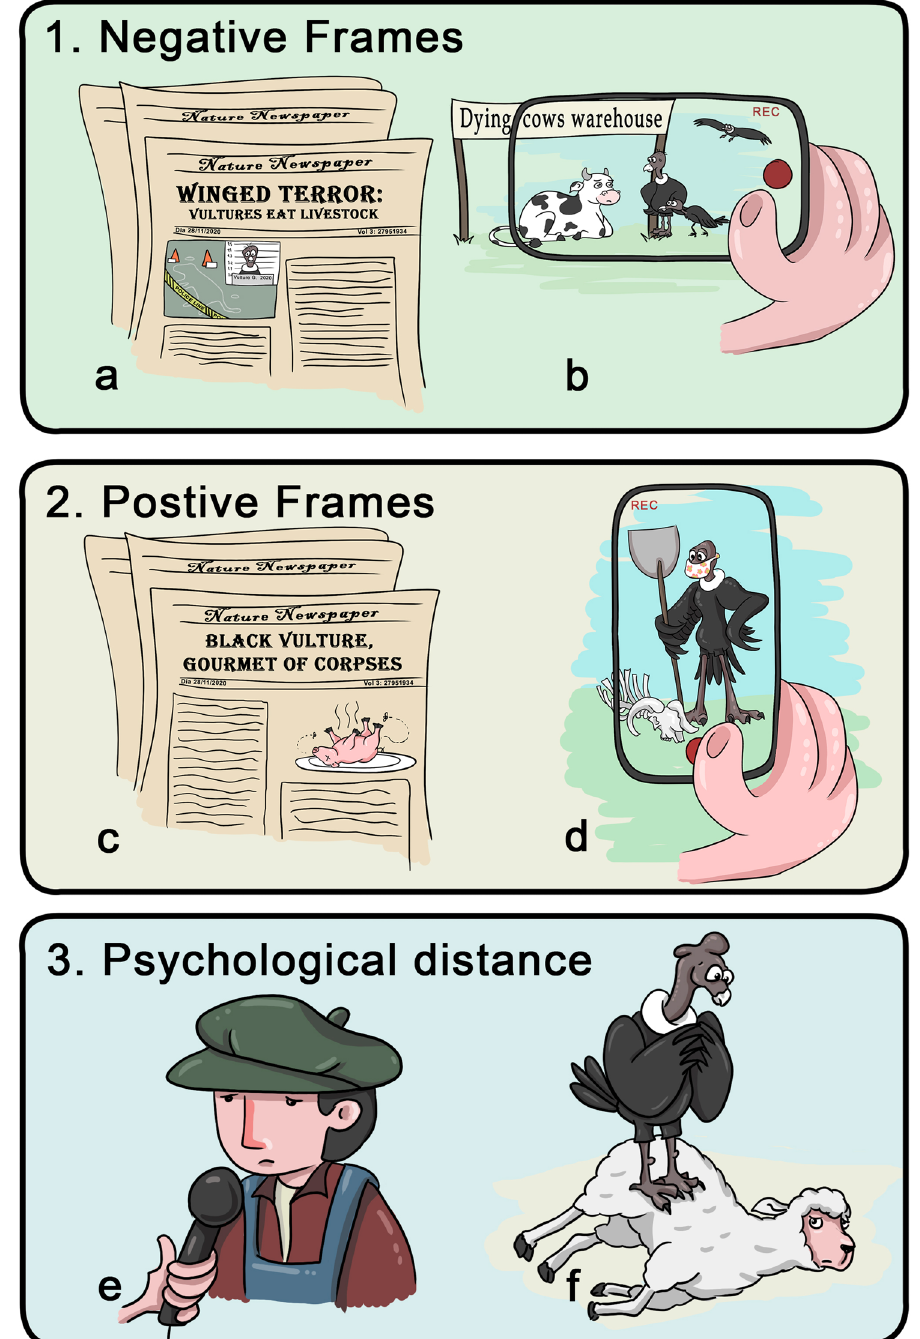
Figure 3. Scheme of the classification of videos according to frame. Negatively framed videos (1), including: ( a ) videos with a negative emphasis in titles or descriptions, ( b ) videos with a negative emphasis in their images. Positively framed videos (2), including ( c ) videos with a positive emphasis in titles or descriptions, ( d ) videos with a positive emphasis in their image. Videos with psychological distance frame (3), including ( e ) close psychological distance videos in which there are farmers’ testimonies about wildlife animals killing their livestock, ( f ) distant psychological distance showing wildlife interacting with livestock but no human testimonies or presence (more details in the main